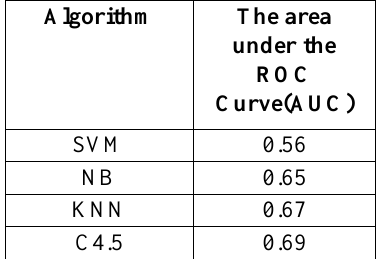
Table 14. Comparison of AUC of the four models